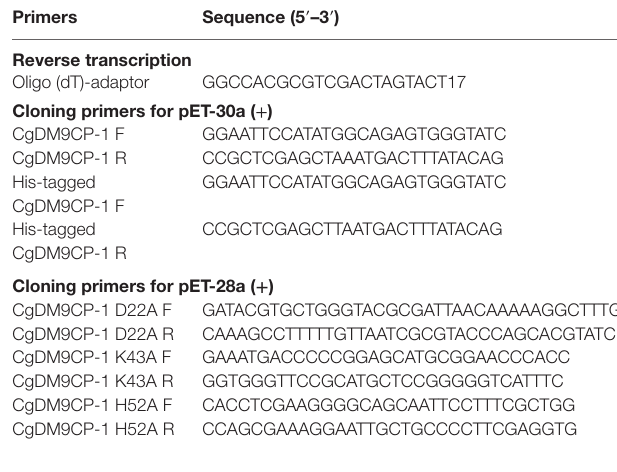
TaBle 1 | Primers used in the present